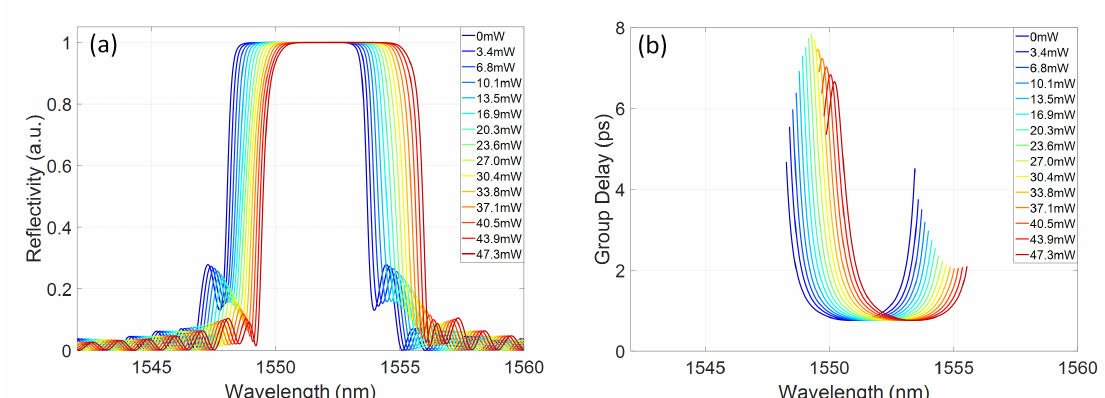
Figure 6. ( a ) Simulated reflectivity; and ( b ) group delay of a Bragg grating device with thermally induced refractive index differences as